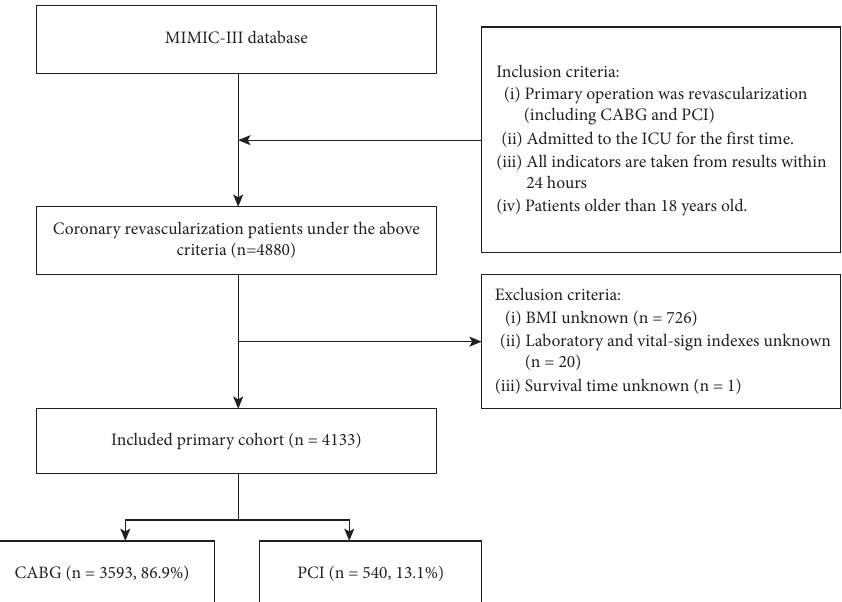
Figure 1: The screening